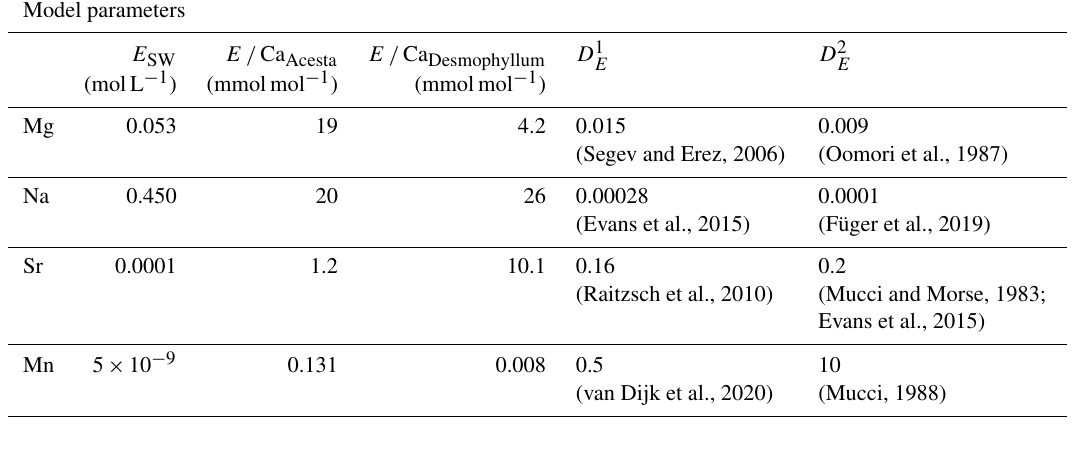
and D 2 represent the distribution coefficient. E E